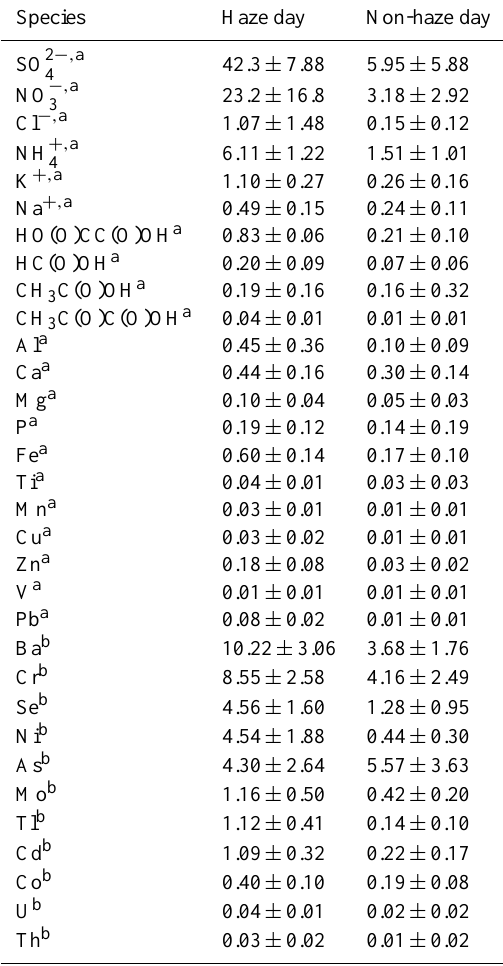
Table 5. The average concentration of ions, organic acids and el- ements of PM 2 . 5 on haze and non-haze days. The errors represent the relative standard